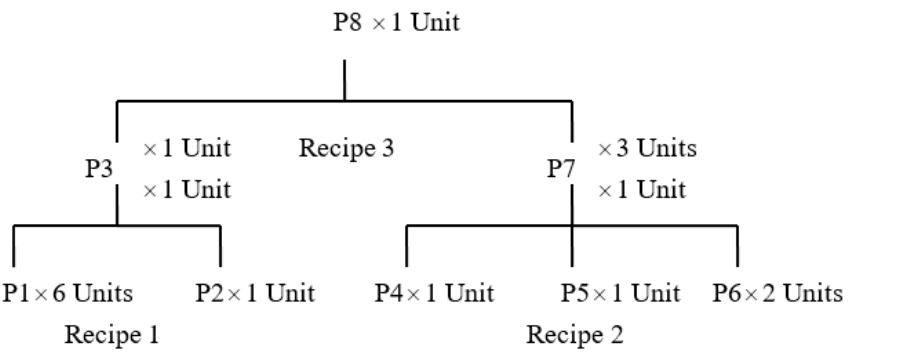
Figure 2. Bill of materials. Table 1. Unit holding costs per time period (4% of unit cost).